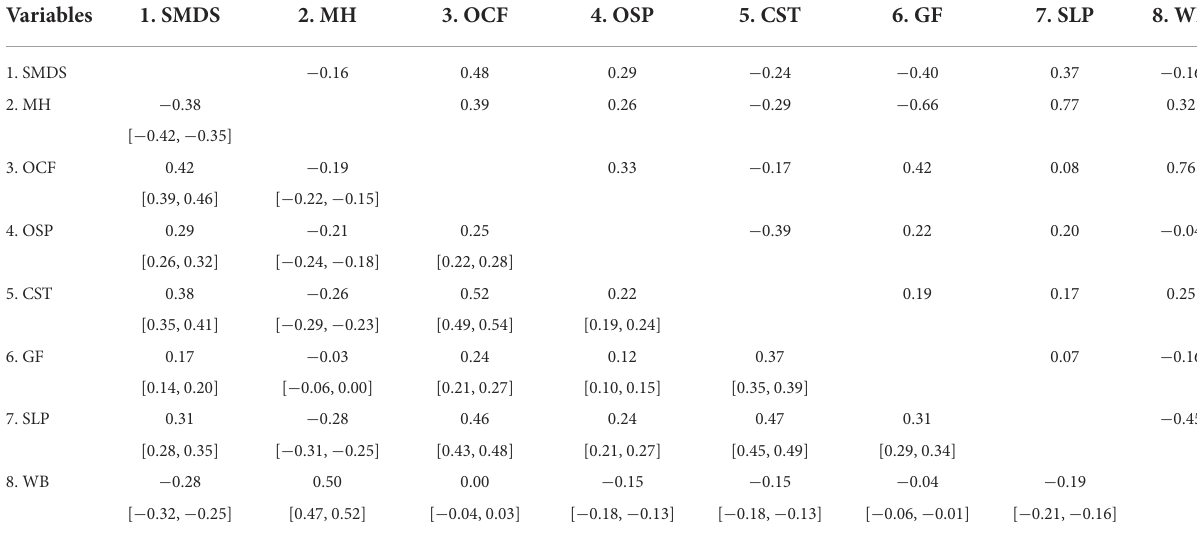
TABLE 4 Correlations among latent